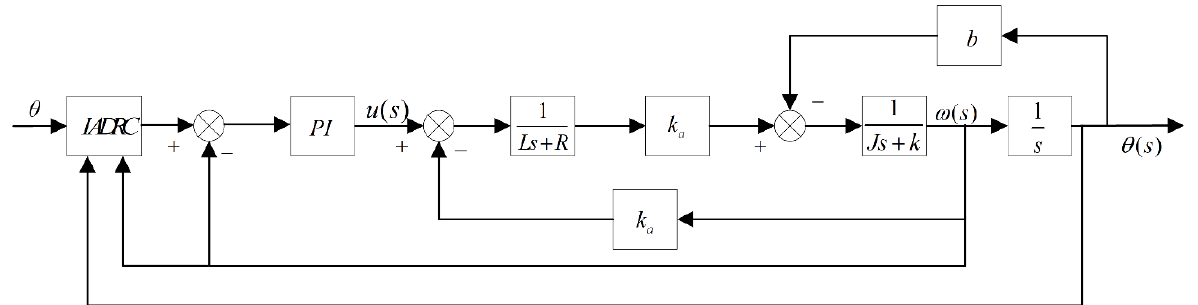
Figure 7. The overall block diagram of the control system.